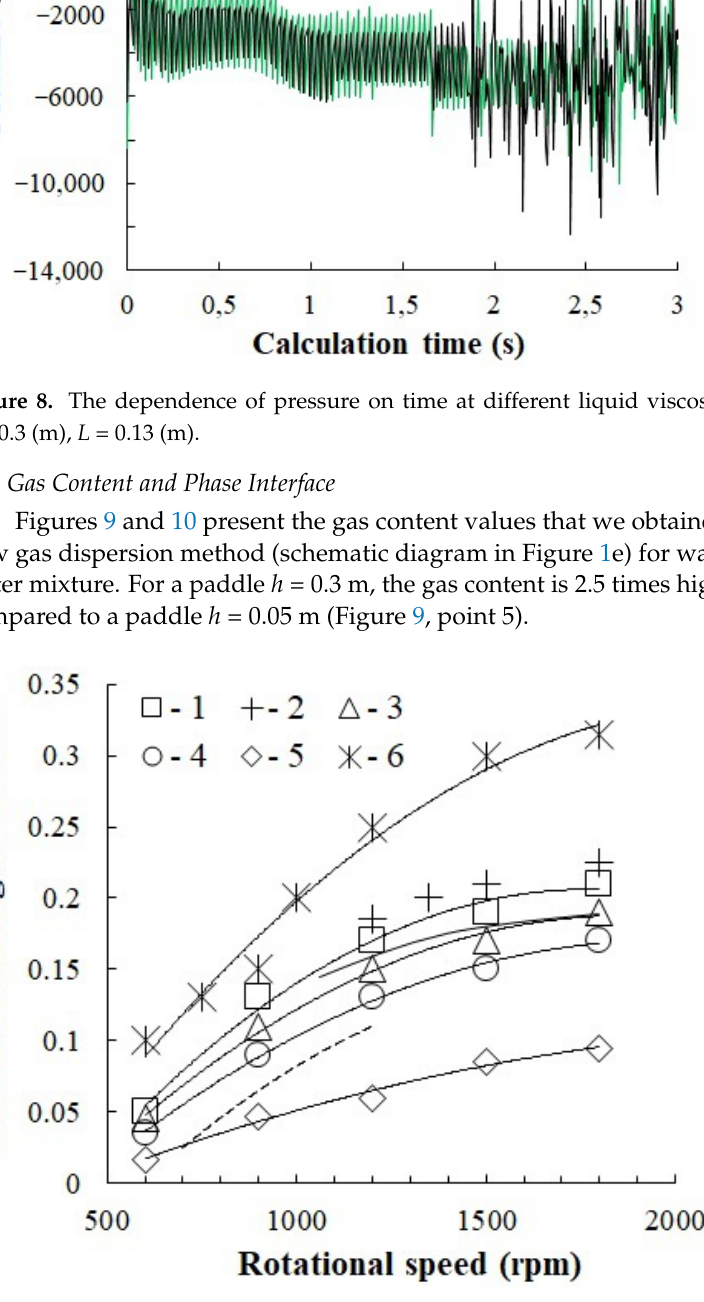
( d ) Figure 7. Scheme of a solid model ( a ) and change in pressure with time ( b – d ) for a liquid with viscosity 10 −6 (m 2 /s), n = 1000 (rpm), h = 0.3 (m): ( b ) L = 0.3 (m); ( c ) L = 0.13 (m); ( d ) L = 0.23 (m); (point 1–3) reading points.